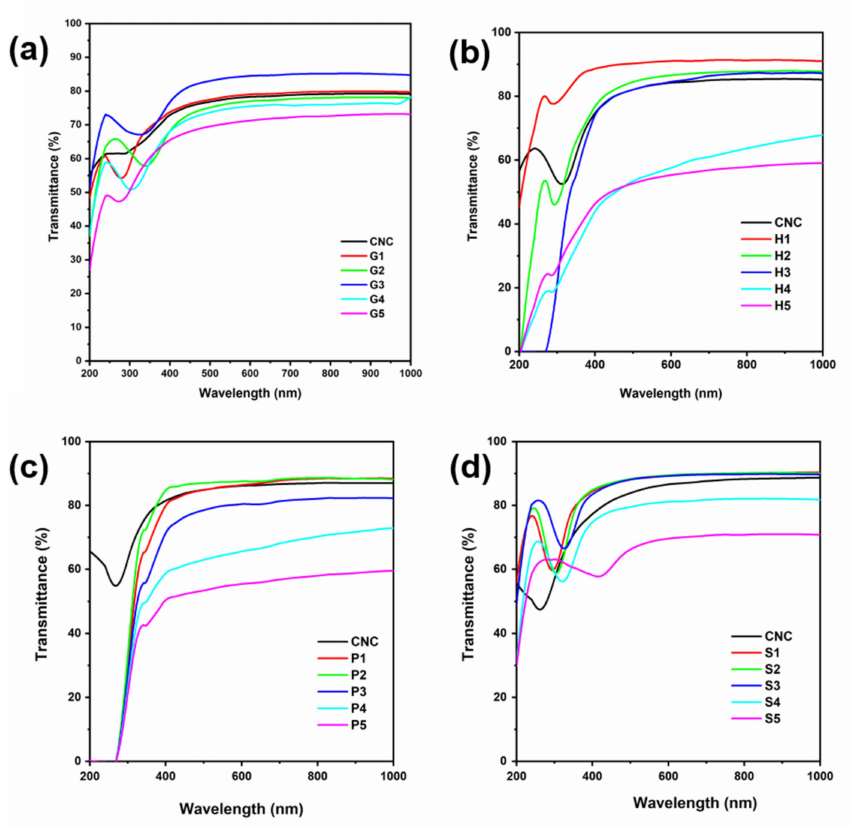
Figure 6. UV–Vis spectra of CNC film and composite films with addition of ( a ) glycine, ( b ) histidine, ( c ) phenylalanine, and ( d )